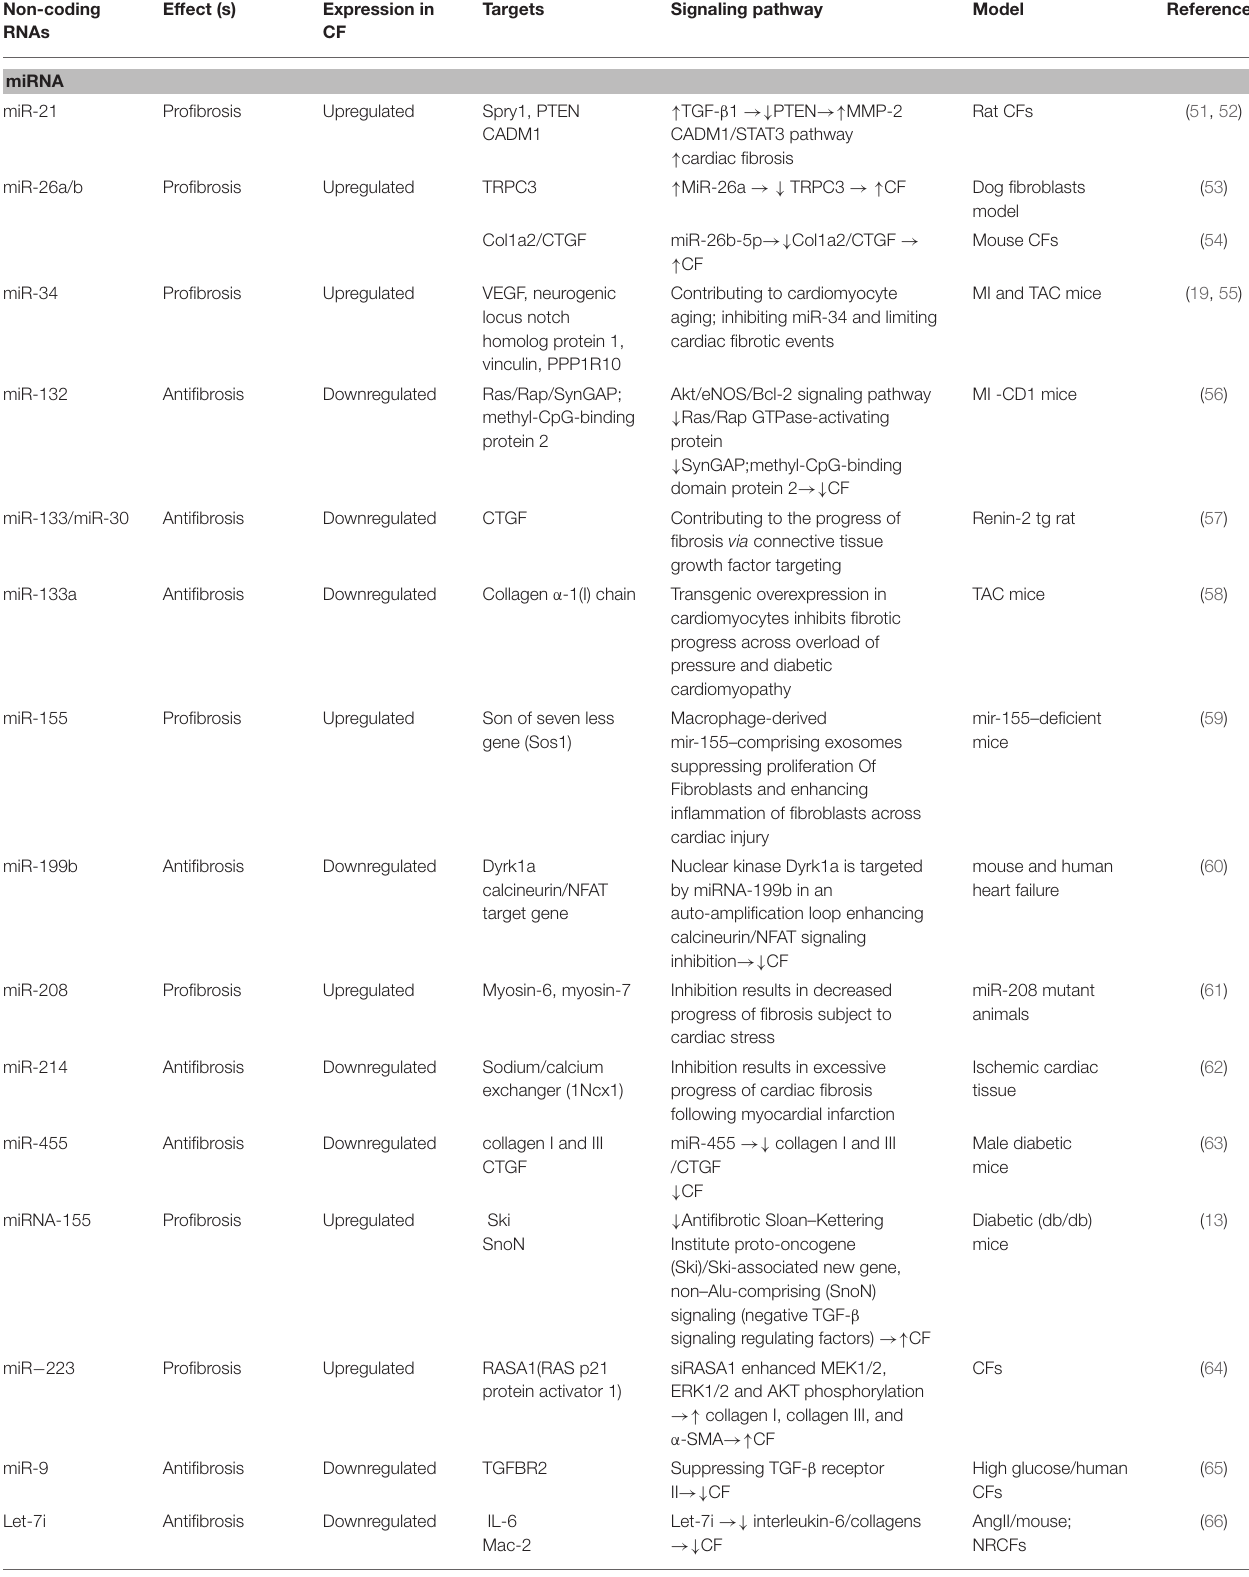
TABLE 1 | ncRNAs contributing to cardiac fibrosis. Non-coding